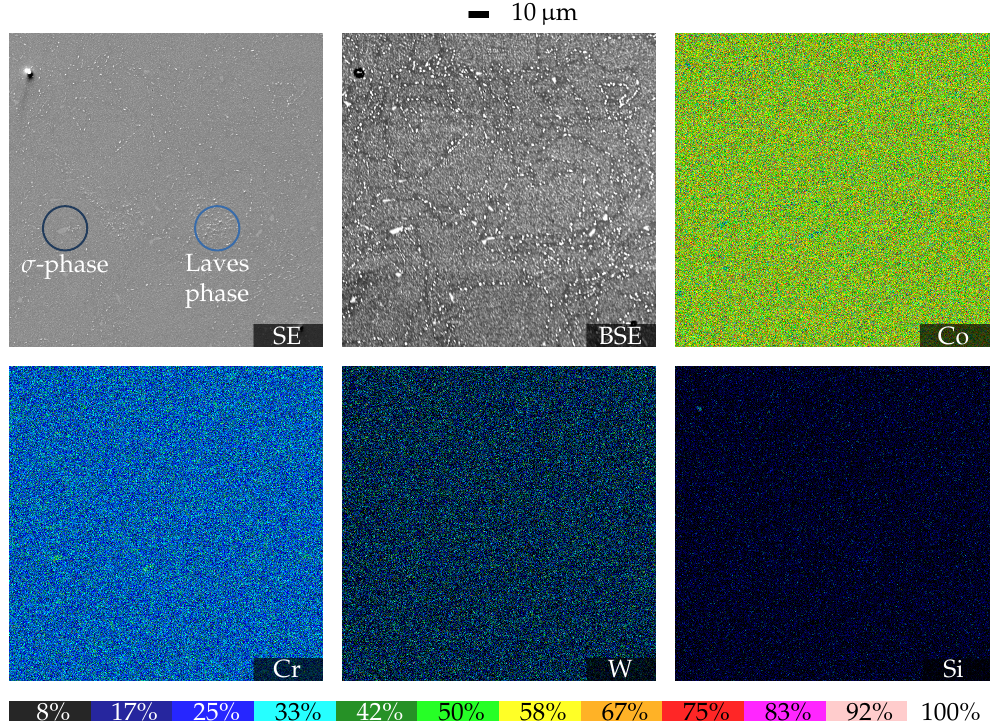
Figure 7. SEM images, measured with secondary electron (SE) and backscattered electron (BSE) detectors, as well as quantitative maps acquired with EDS of the bulk in sample 4 after HT with T HT4 ( T S ≈ 908 ◦ C). Spotty dots: Laves-phase; Light gray patches: σ